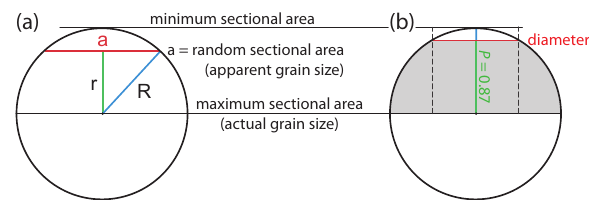
Figure 1. (a) Possible sections through a circle (sphere projection). R is the radius, a the section or chord length of a random section and r the apothem, this is, the distance from the centre of the circle to the midpoint of the section length. The chord length corresponds with the apparent diameter and ranges between 0 and the actual diameter of the grain when the section cuts through the centre of the circle. (b) Example showing an apparent section that corresponds to half of the actual diameter. The sketch illustrated that when a sphere is cut through randomly, it is most likely ( P = 0 . 87) to obtain diameters larger than half of the diameter than the